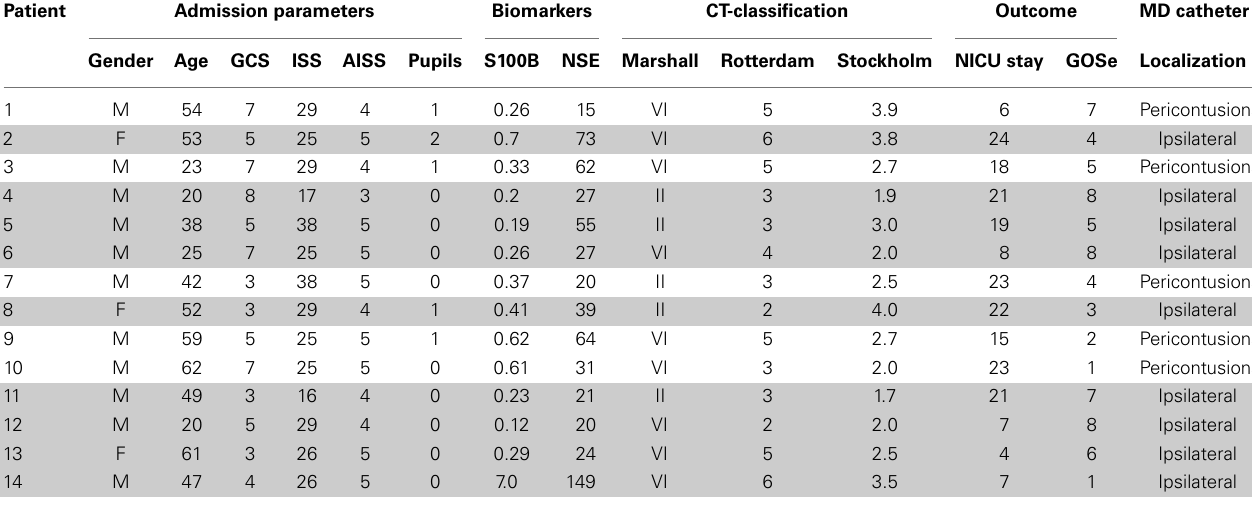
Table illustrating patient demographic data. The patients with pericontusional microdialysis catheters are in white rows, while the rows of patients with ipsilateral microdialysis catheters are